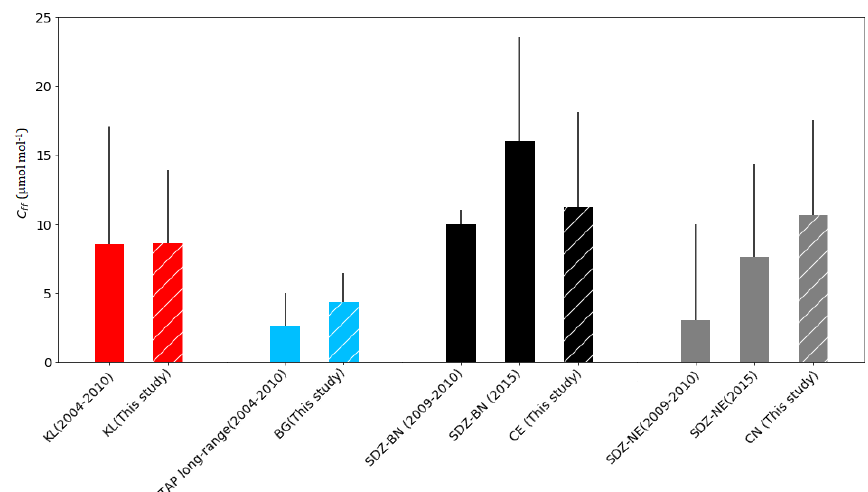
Figure 3. Calculated C ff (µmolmol − 1 ). Red bars are for KL, and blue bars are for South Korean long-range-transported samples (from China) (2004–2010 from Turnbull et al., 2011a). Black bars are for SDZ-BN samples that were affected by Beijing and the North China Plain. Gray bars for SDZ-NE indicate samples that were affected by regions northeast of SDZ. SDZ (2009–2010) is from Turnbull et al. (2011a), and SDZ (2015) is from Niu et al. (2016). Hatched red, blue, black, and gray bars are derived from this study during 2014 to